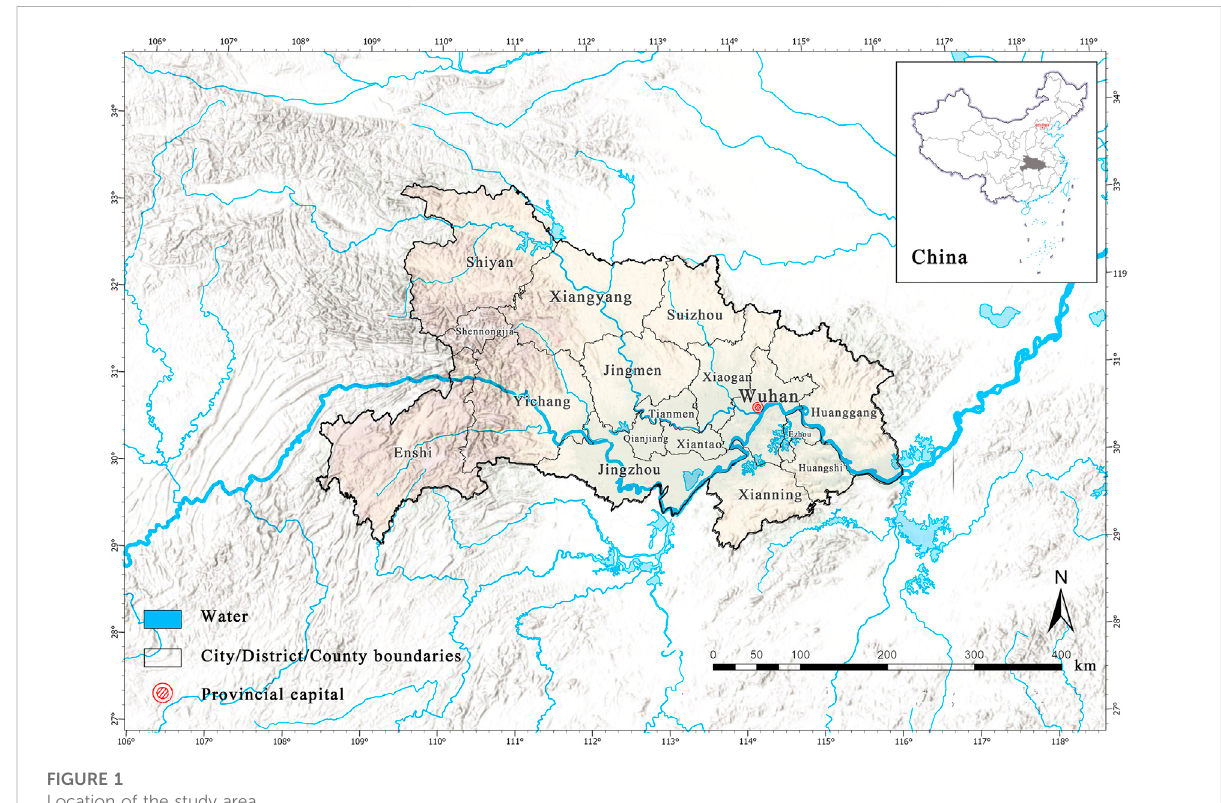
FIGURE 1 Location of the study